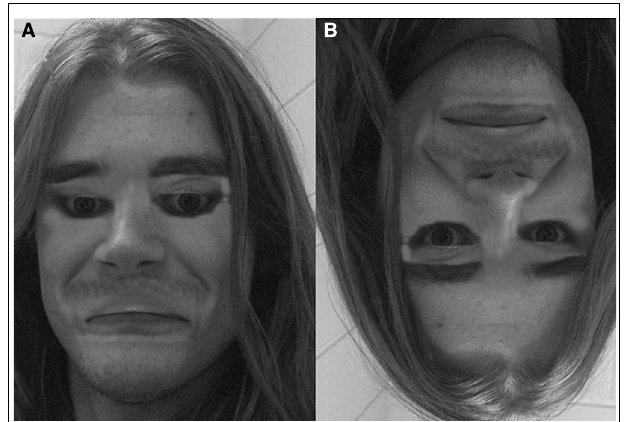
FIGURE 1 | An example of bizarre experience elicited by faces whose spatial elements are denaturalized. (A) In the so-called Thatcher Illusion, the eyes and mouth of the upright face are turned upside-down. (B) The feeling of bizarreness produced by the manipulation disappears when the image is inverted.